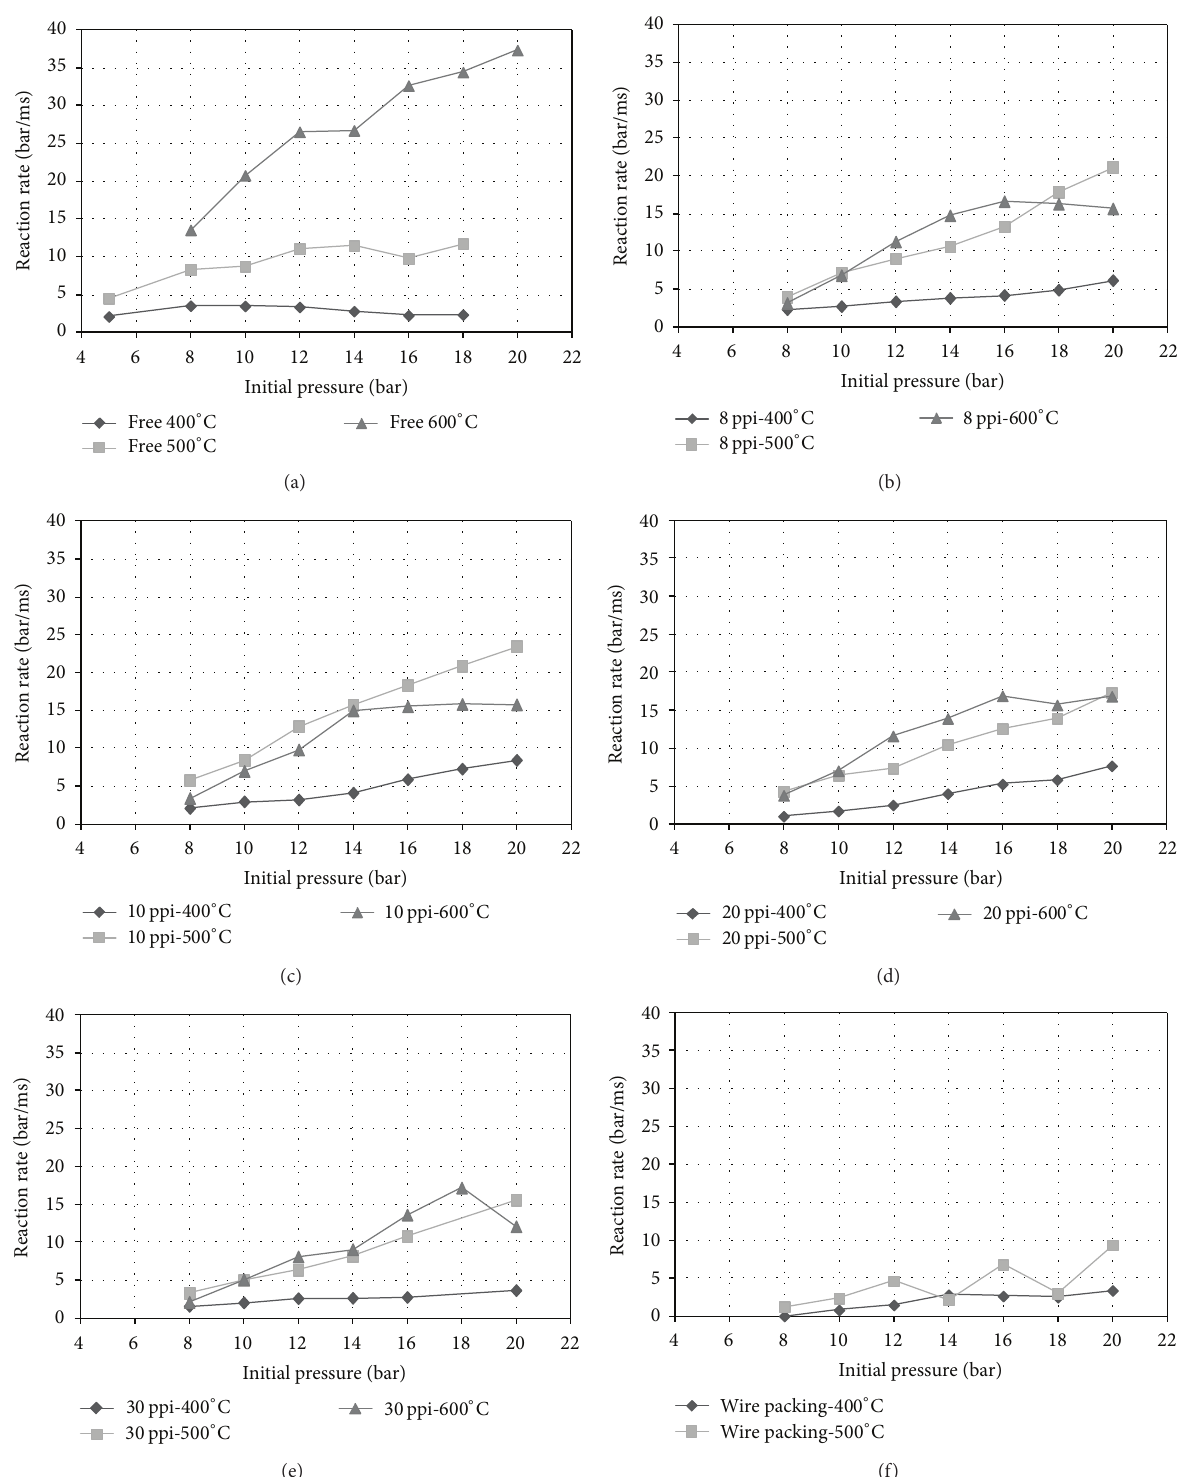
Figure 16: Comparison of pressure gradient (reaction rate) for heat release in free volume and in different porous reactors (SiC foam reactors and steel wire packing reactor) as a function of initial pressure 𝑝 fuel is 23.7